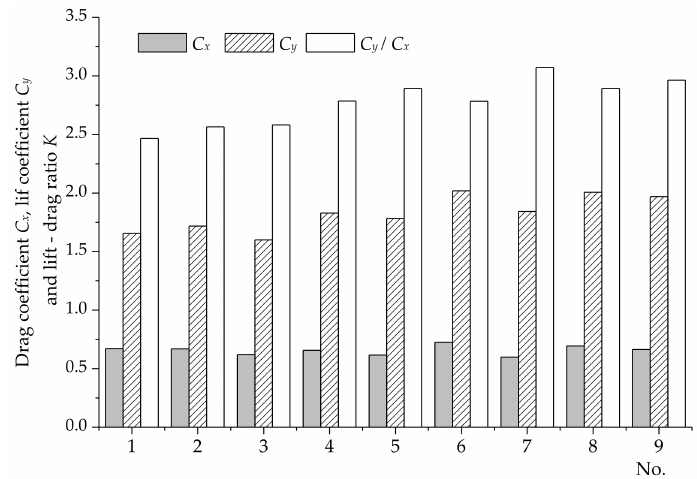
Figure 11. C x , C y , and K of the otter board models for an angle of attack of 30 ◦ .